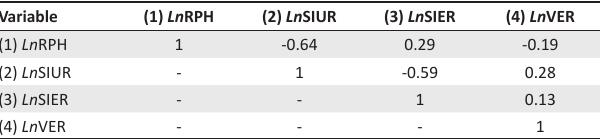
TABLE 1: Pearson correlation coefficients ( N = 115); major code 71 (digits 712, 713 and 714).